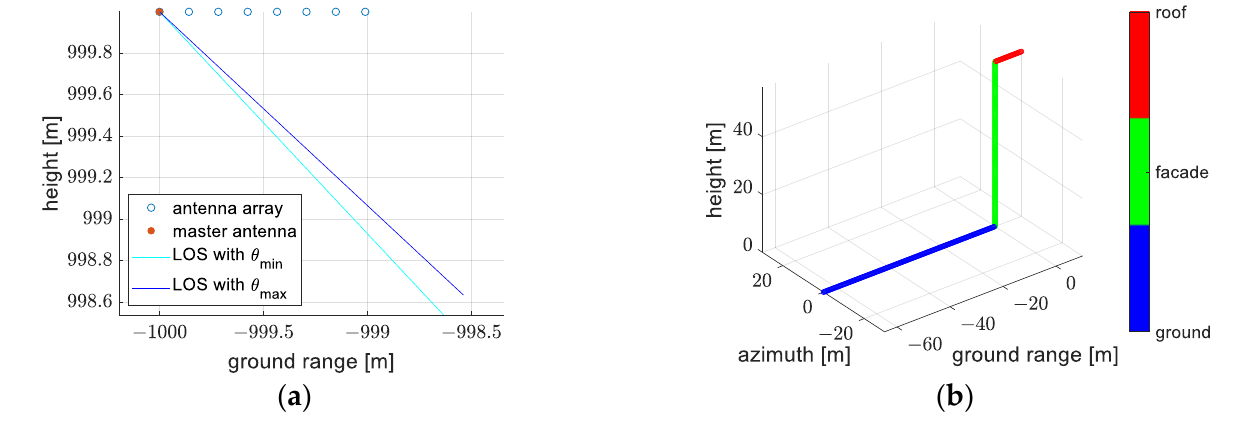
Figure 7. ( a ) Configuration of the antenna array; ( b ) structure of the simulated scene in ground frame. Table 2. Parameters of simulated